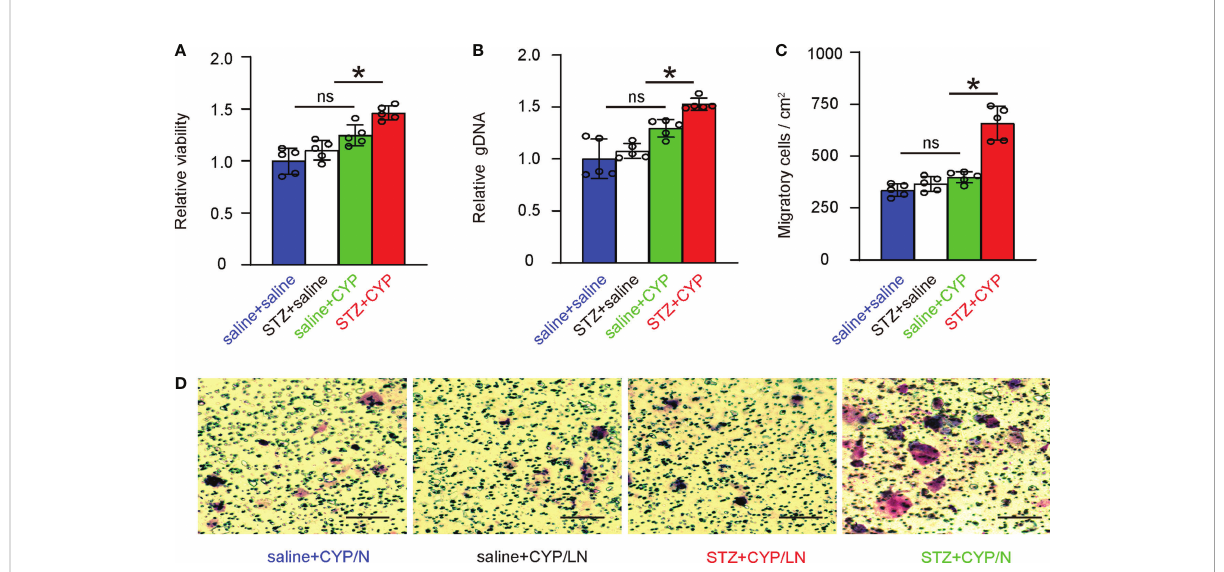
FIGURE 5 Diabetes increases growth and migration potential of macrophages from in fl ammatory bladder. (A, B) Bladder macrophages from 4 groups of the mice were analyzed for cell growth in a CCK-8 assay (A) and in assay to determine DNA (B) . (C, D) Bladder macrophages from 4 groups of the mice were analyzed for migration, shown by quanti fi cation (C) and by representative images (D) . *p<0.05. ns: no signi fi cance. Scale bars are